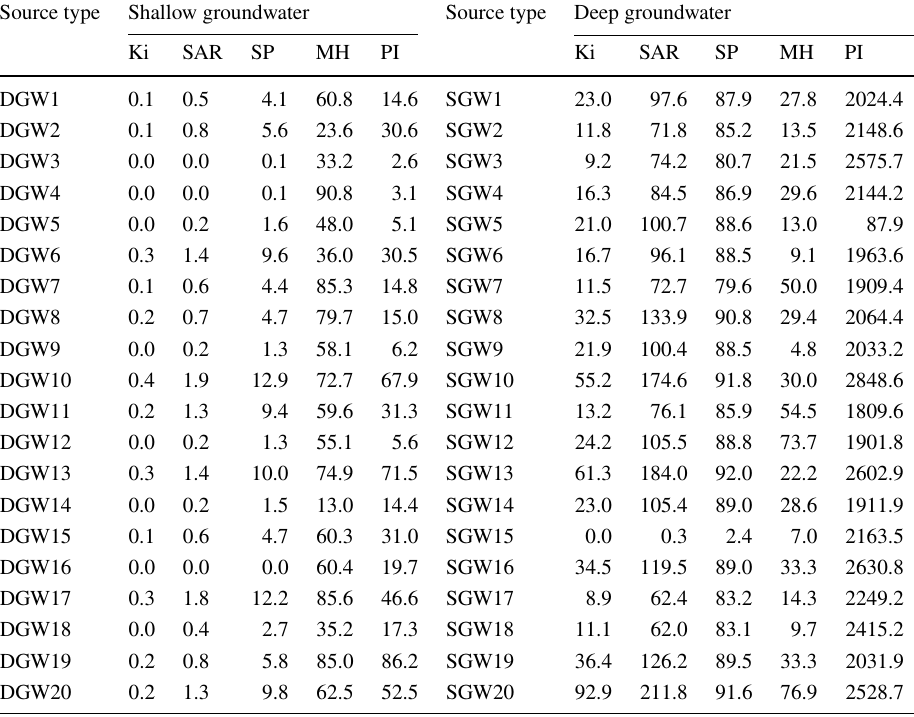
Table 13 Summary of chemical indices of shallow and deep groundwater in the study area